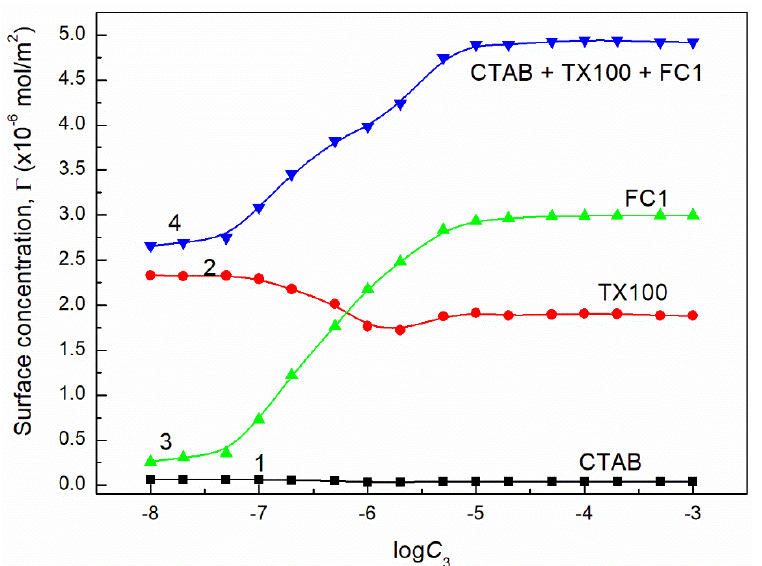
Figure 15. A plot of the concentration of CTAB (curve 1), TX100 (curve 2), FC1 (curve 3) and their sum (curve 4) in the mixed monolayer at the water-air interface formed by the CTAB + TX100 + FC1 mixture at the constant concentration of the binary CTAB + TX100 mixture ( C 12 ) and γ LV = 60 mN/m as well as calculated from Equation (12) based the contribution of the given surfactant to the reduction of water surface tension vs. the logarithm of the FC1 concentration ( logC 3 ).